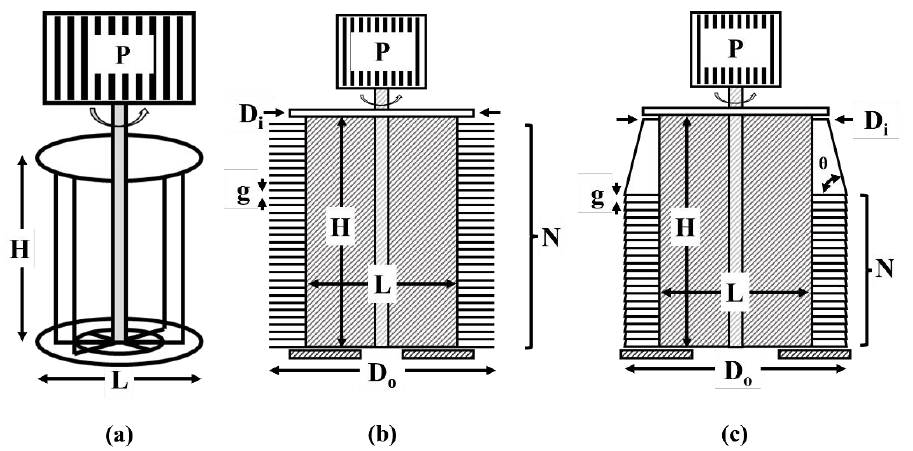
Figure 1. Schematic of the cyclone separator: ( a ) no disks attached; ( b ) flat disks attached; ( c ) cone-shaped disks attached.